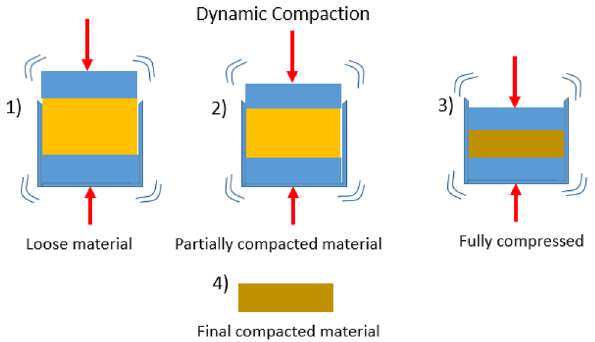
Fig. 2 Diagram of the dynamic high-pressure compaction system, showing a reduction of the cement by ~ 40% by volume in the fully pressed material